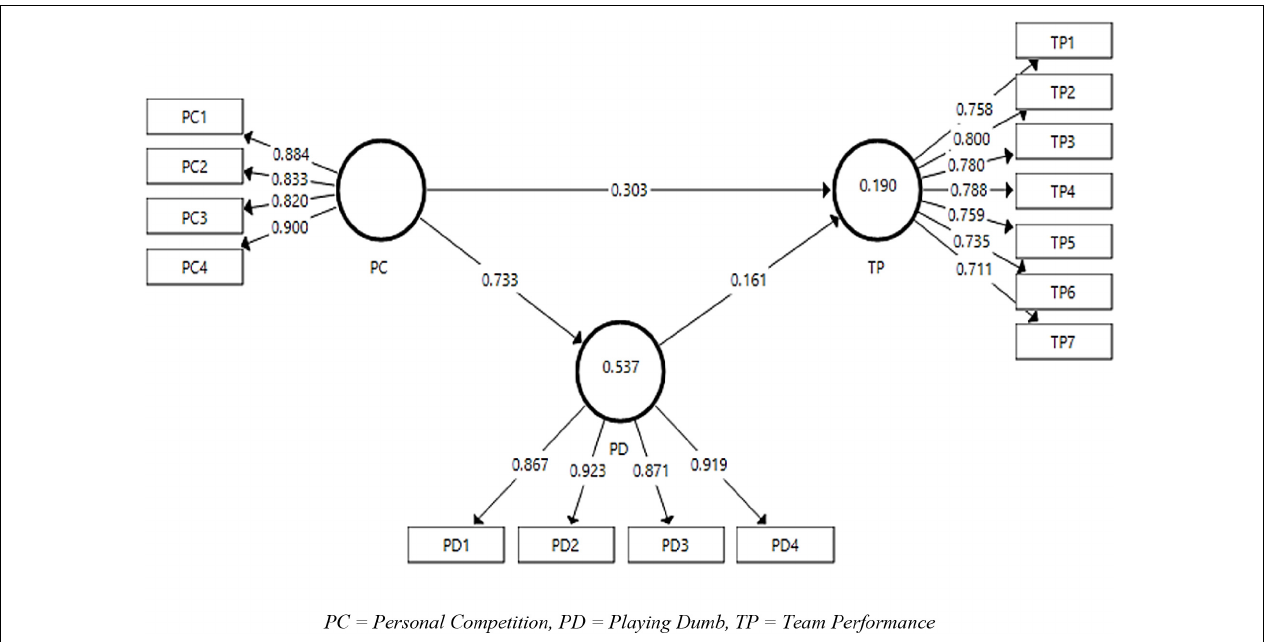
FIGURE 2 | The output of the measurement model algorithm. PC, personal competition; PD, playing dumb; TP, team